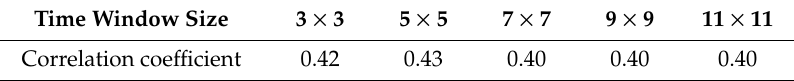
Table 4. Correlation coe ffi cient for di ff erent time windows with 10% noise. Table 5. Correlation coefficient for different time windows with 20% noise.